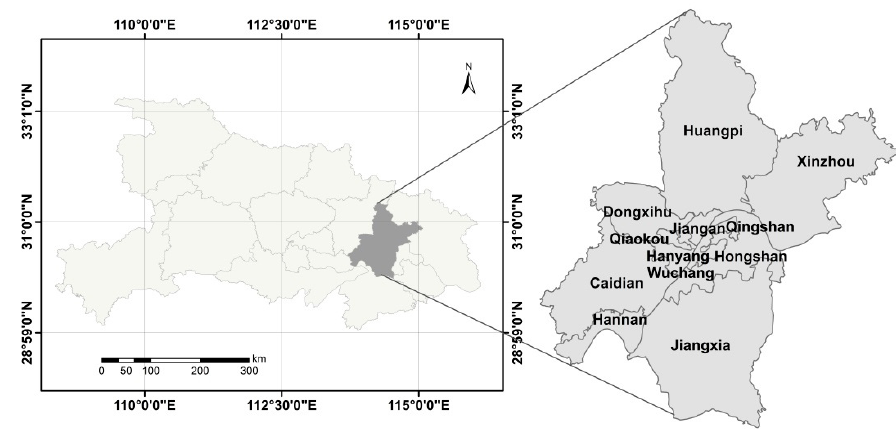
Figure 1. Location of study area.